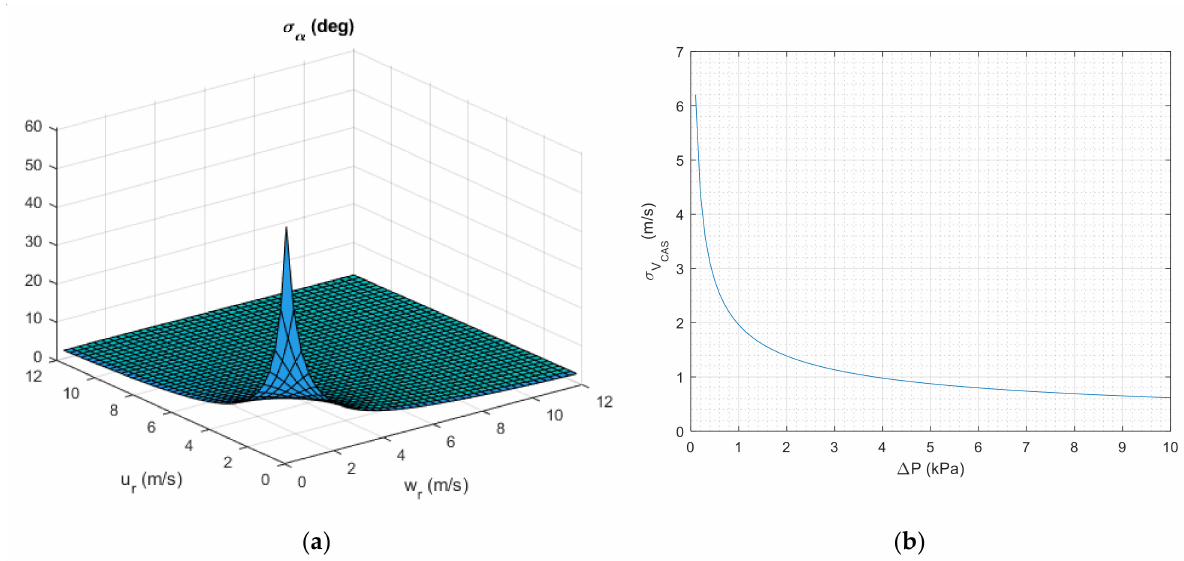
Figure 2. ( a ) Standard deviation (in degrees) of the AOA, α , as a function of the measured velocity components. ( b ) Standard deviation of the calibrated